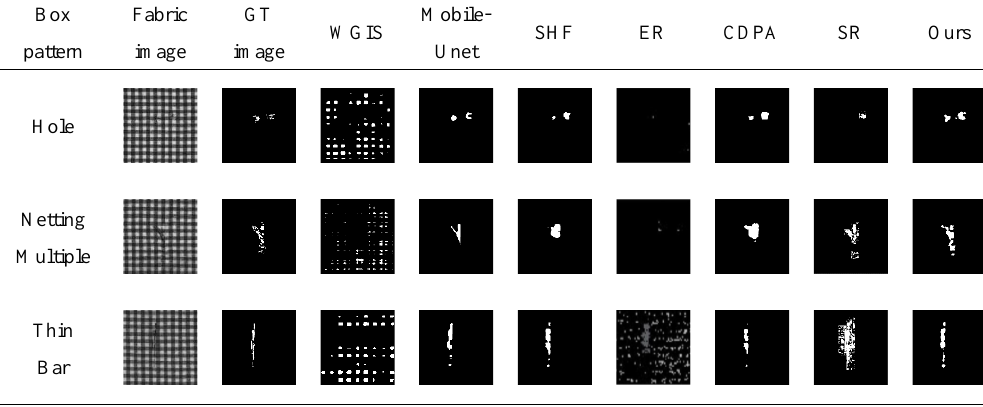
Figure 14. Each row depicts the detect inspection exemplars for 7 algorithms of a specific detection type. From top to bottom, these types are Hole, Netting Multiple and Thin Bar.